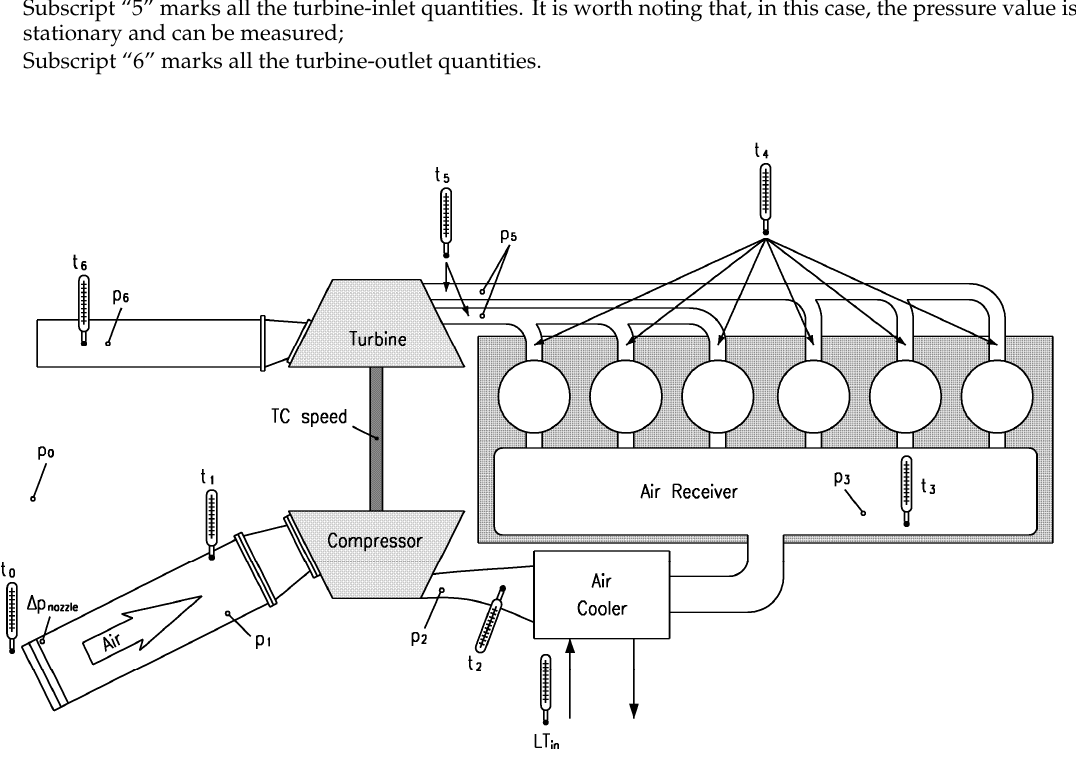
Figure A1. WIT convention: single-stage case.